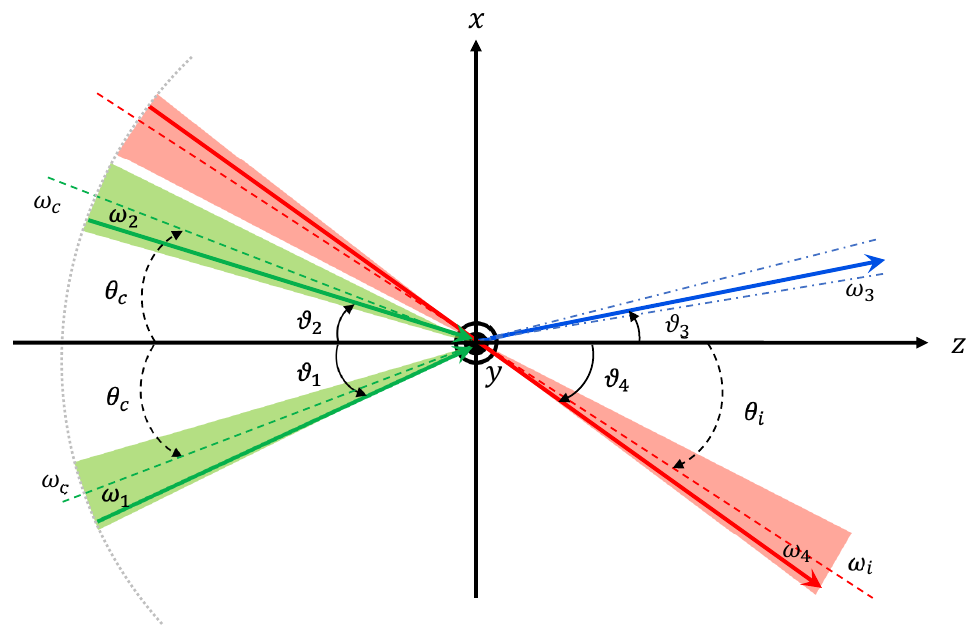
Figure 1. Concept of a three-beam stimulated resonant photon collider ( t SRPC) with focused coher- ent